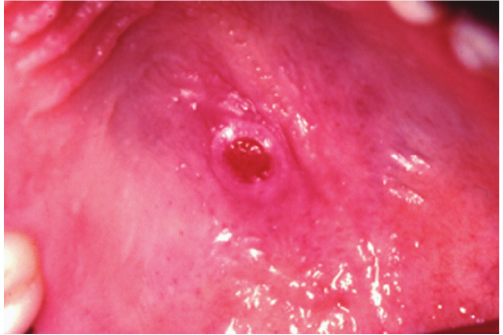
Figure 1: The clinical photograph shows a lesion on the posterior hard palate, asymptomatic, well limited, and raised edges.